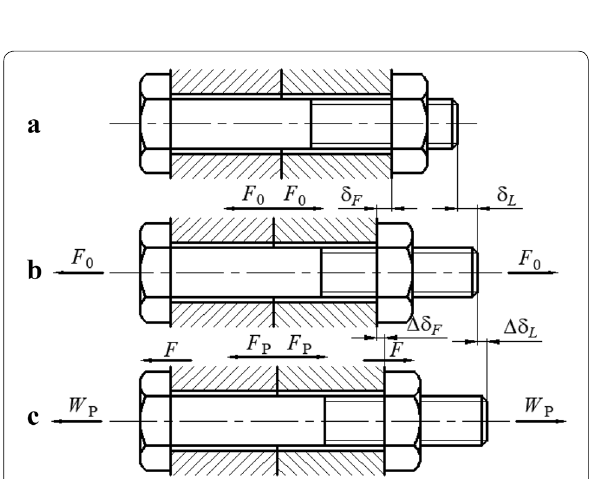
Figure 2 Diagram of bolt load and deformation [4]: a